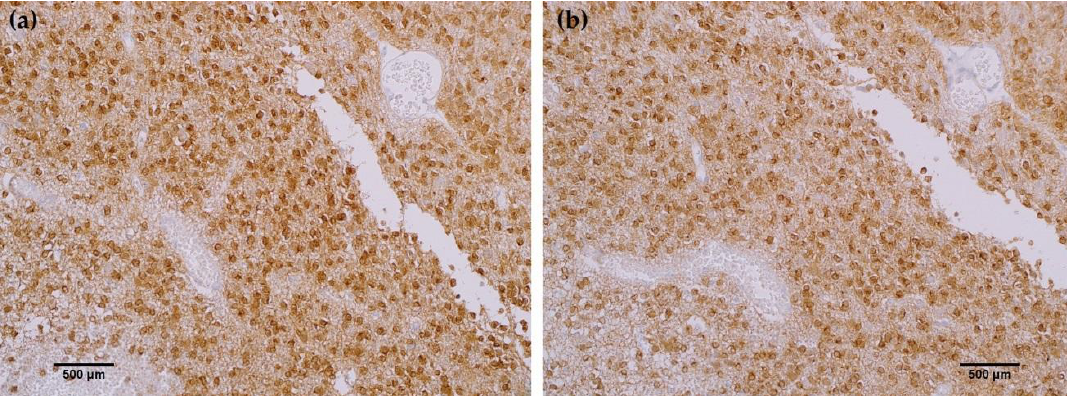
Figure 3. Comparison immunohistochemistry (IHC) staining results with MRQ-67 and H09 in oligodendroglioma: ( a ) Strong cytoplasmic and weak nuclear labeling of tumor cells with MRQ-67 in a case of WHO grade II oligodendroglioma (200×); ( b ) Comparable cytoplasmic and nuclear staining of tumor cells with H09 in the same case of oligodendroglioma (200×).